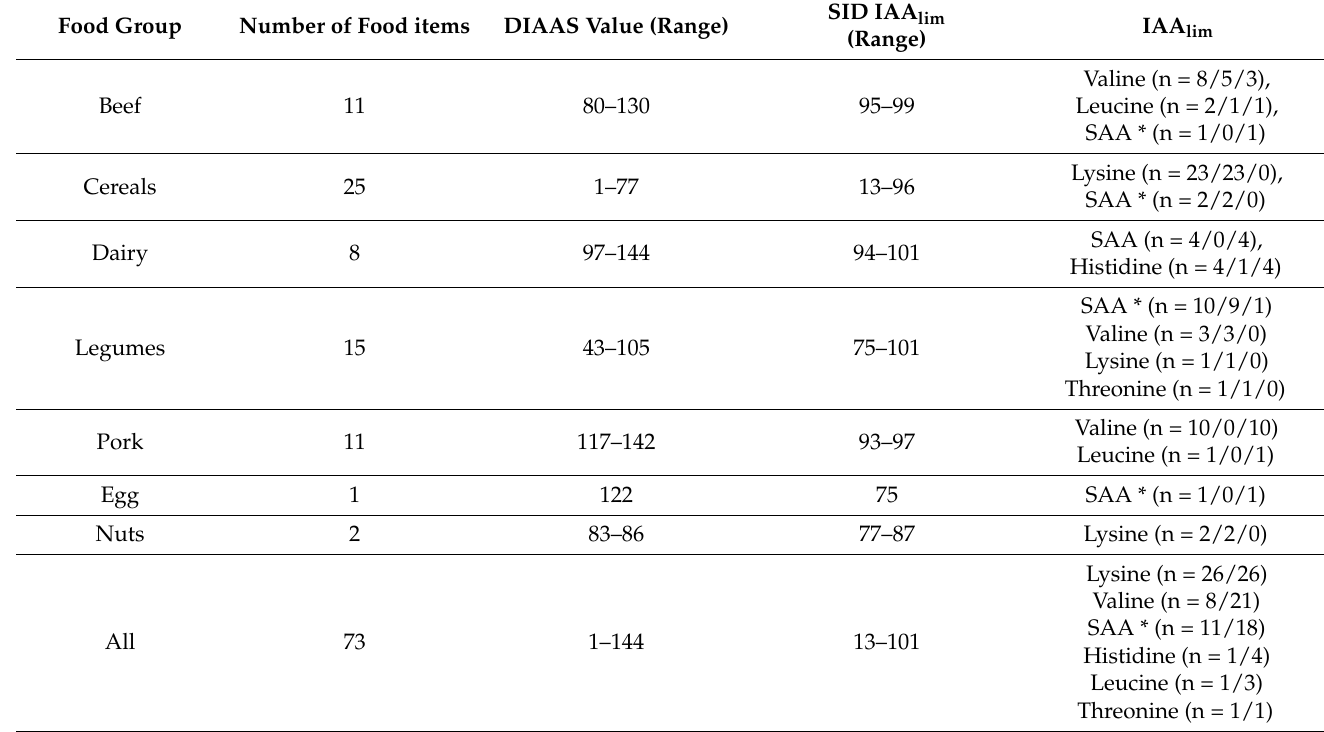
Table 5. Overviewed of the range for digestible indispensable amino acid score (DIAAS) values, the first limiting indispensable amino acid (IAA lim ) and its standardized ileal digestibility (SID) for different food groups. For IAA lim , data in brackets indicate total amount of times the IAA was IAA lim in the food group, followed by the number of occurrences for which this was for a product with DIAAS < 100 and the number of occurrences for which this was for a product with DIAAS >